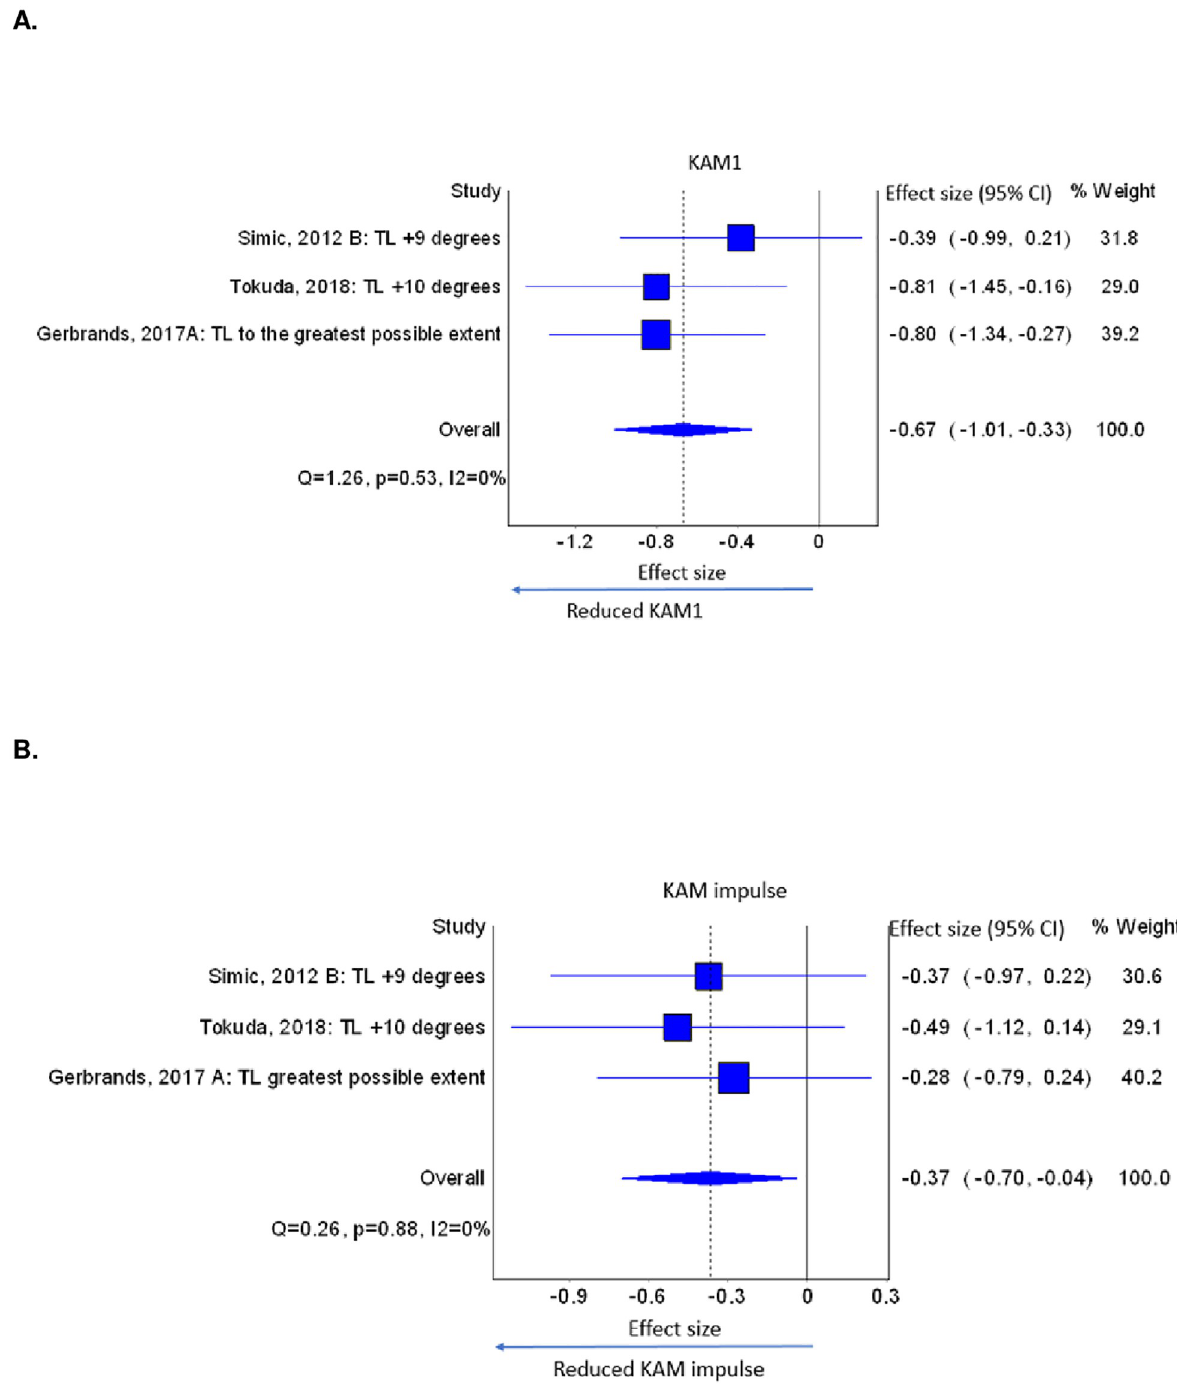
Fig 2. A. Effects of trunk lean on KAM1, B. KAM impulse. (TL: Trunk lean, KAM1: early stance phase peak external knee adduction moment, KAM impulse: external knee adduction moment impulse).